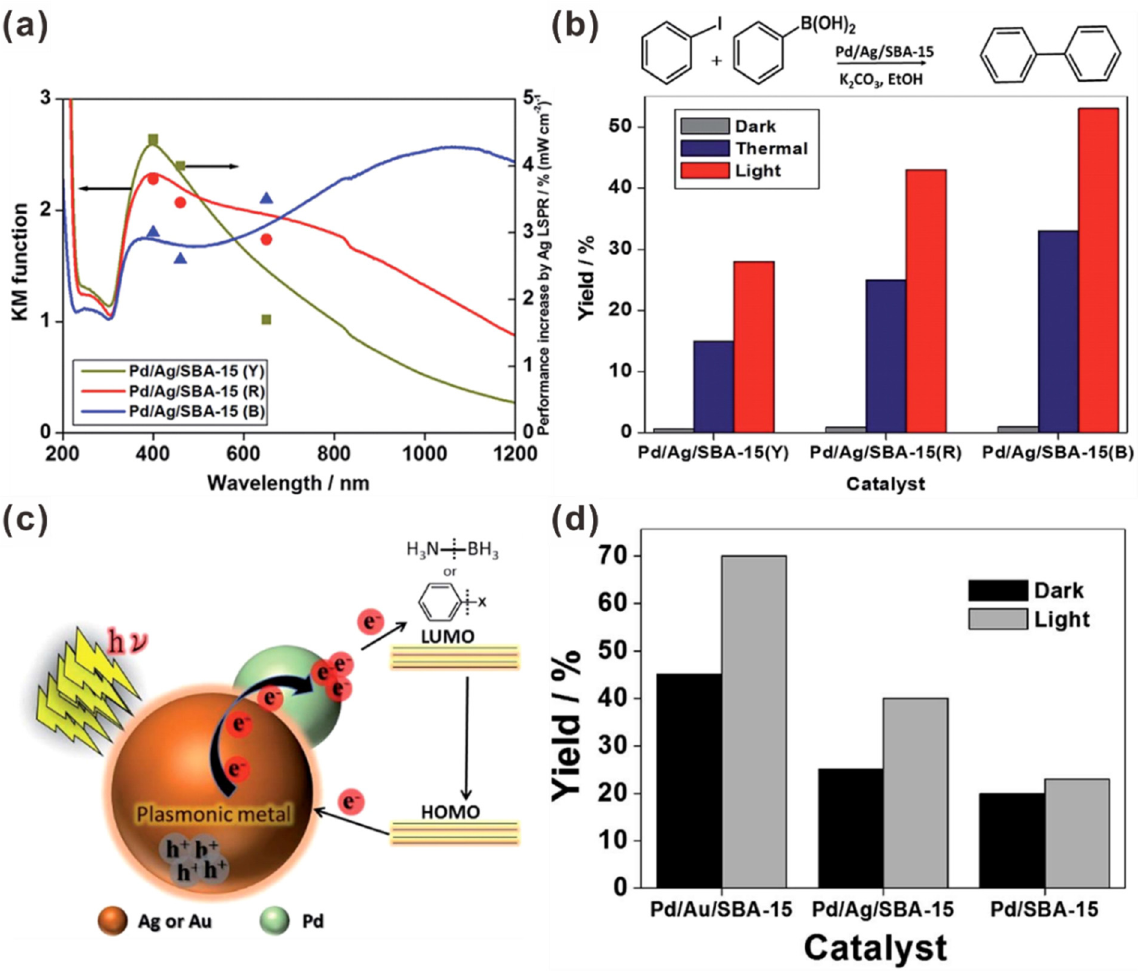
Figure 13. Pd/Ag bimetallic nano-catalysts on mesoporous silica for photocatalytic Suzuki coupling. ( a ) UV-vis spectra and wavelength dependence of the photocatalysts, ( b ) the catalytic activities of Pd/Ag/SBA-15 catalysts with different SBA-15, ( c ) the mechanism for the enhanced photocatalytic activity, and ( d ) the catalytic activities of Pd/metal/SBA-15. Reproduced with permission from References [113,133]. Copyright 2015 and 2016 Royal Society of Chemistry.